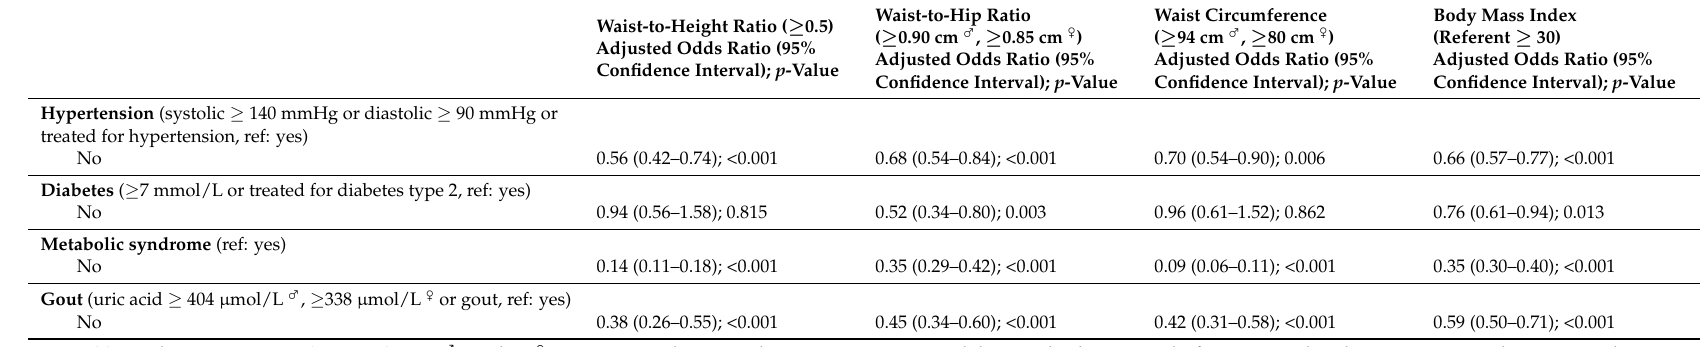
MDSS: Mediterranean Diet Serving Score. : males. : woman. Multivariate logistic regression models were built separately for waist-to-height ratio, waist-to-hip ratio and waist ♀ ♂ circumference. A multivariate ordinal regression model was used for the analysis of the characteristics associated with Body Mass Index (BMI). Adjusted odds ratios, 95% confidence intervals and p -Values were calculated using multivariate regression models; each of the four models was simultaneously adjusted for all covariates listed in this table. Table 4. Characteristics associated with unfavorable biochemical parameters; lipid levels as determined by the multivariate logistic regression models and elevated fibrinogen as determined by ordinal regression model (sample size is 4011 subjects without previous cardiovascular disease diagnosis; all independent variables included in the model are listed in the